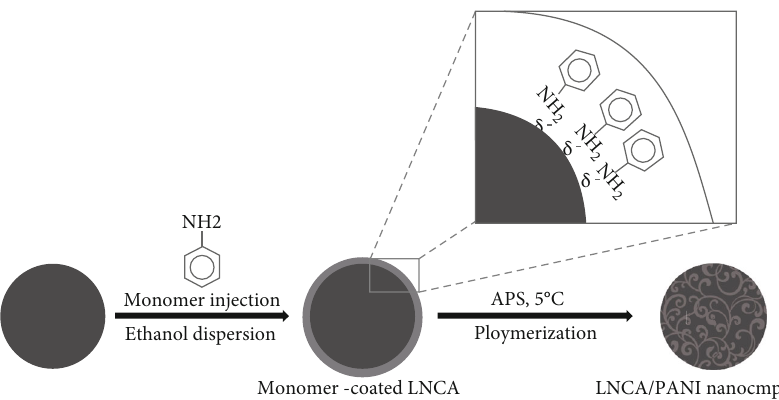
Figure 4: A scheme illustrating the LNCA material surface coated by polyaniline